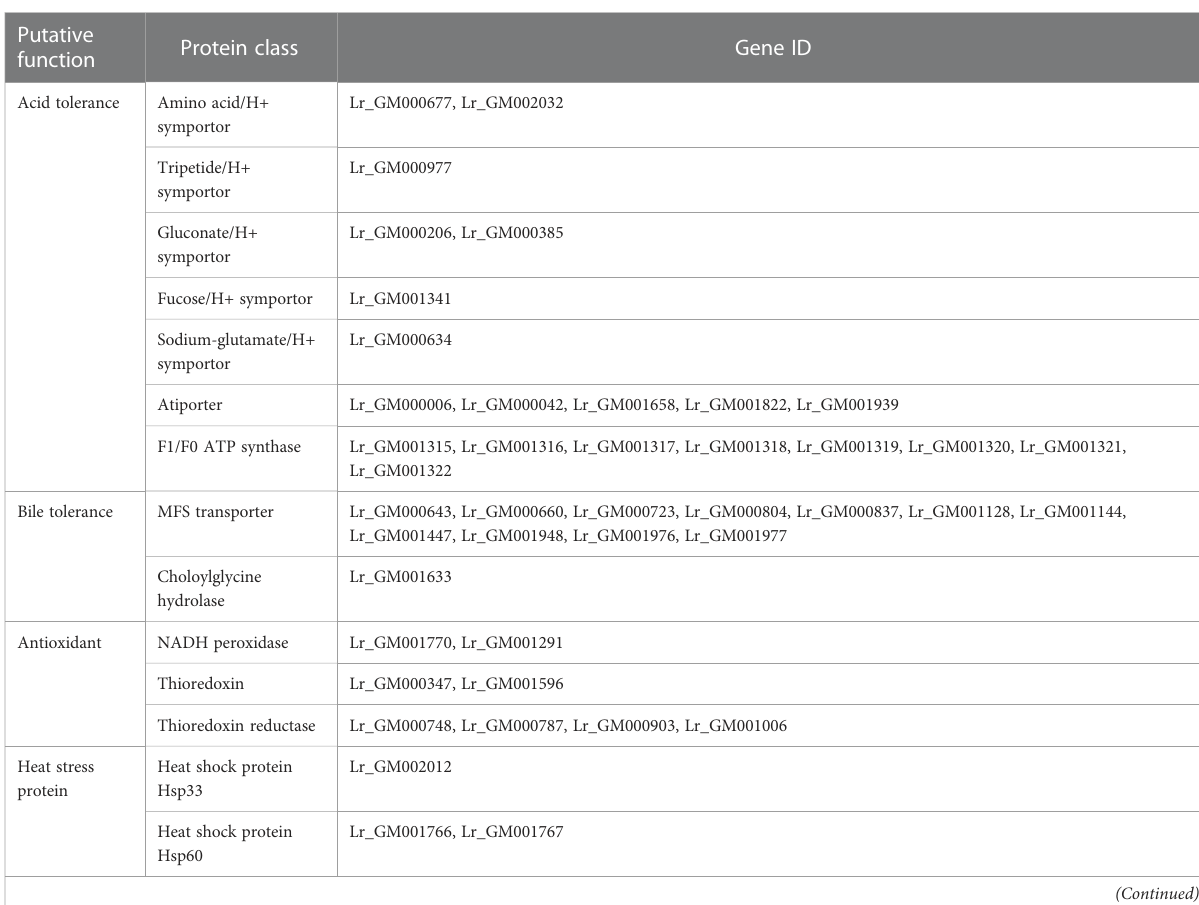
TABLE 1 List of putative probiotic genes of L. reuteri